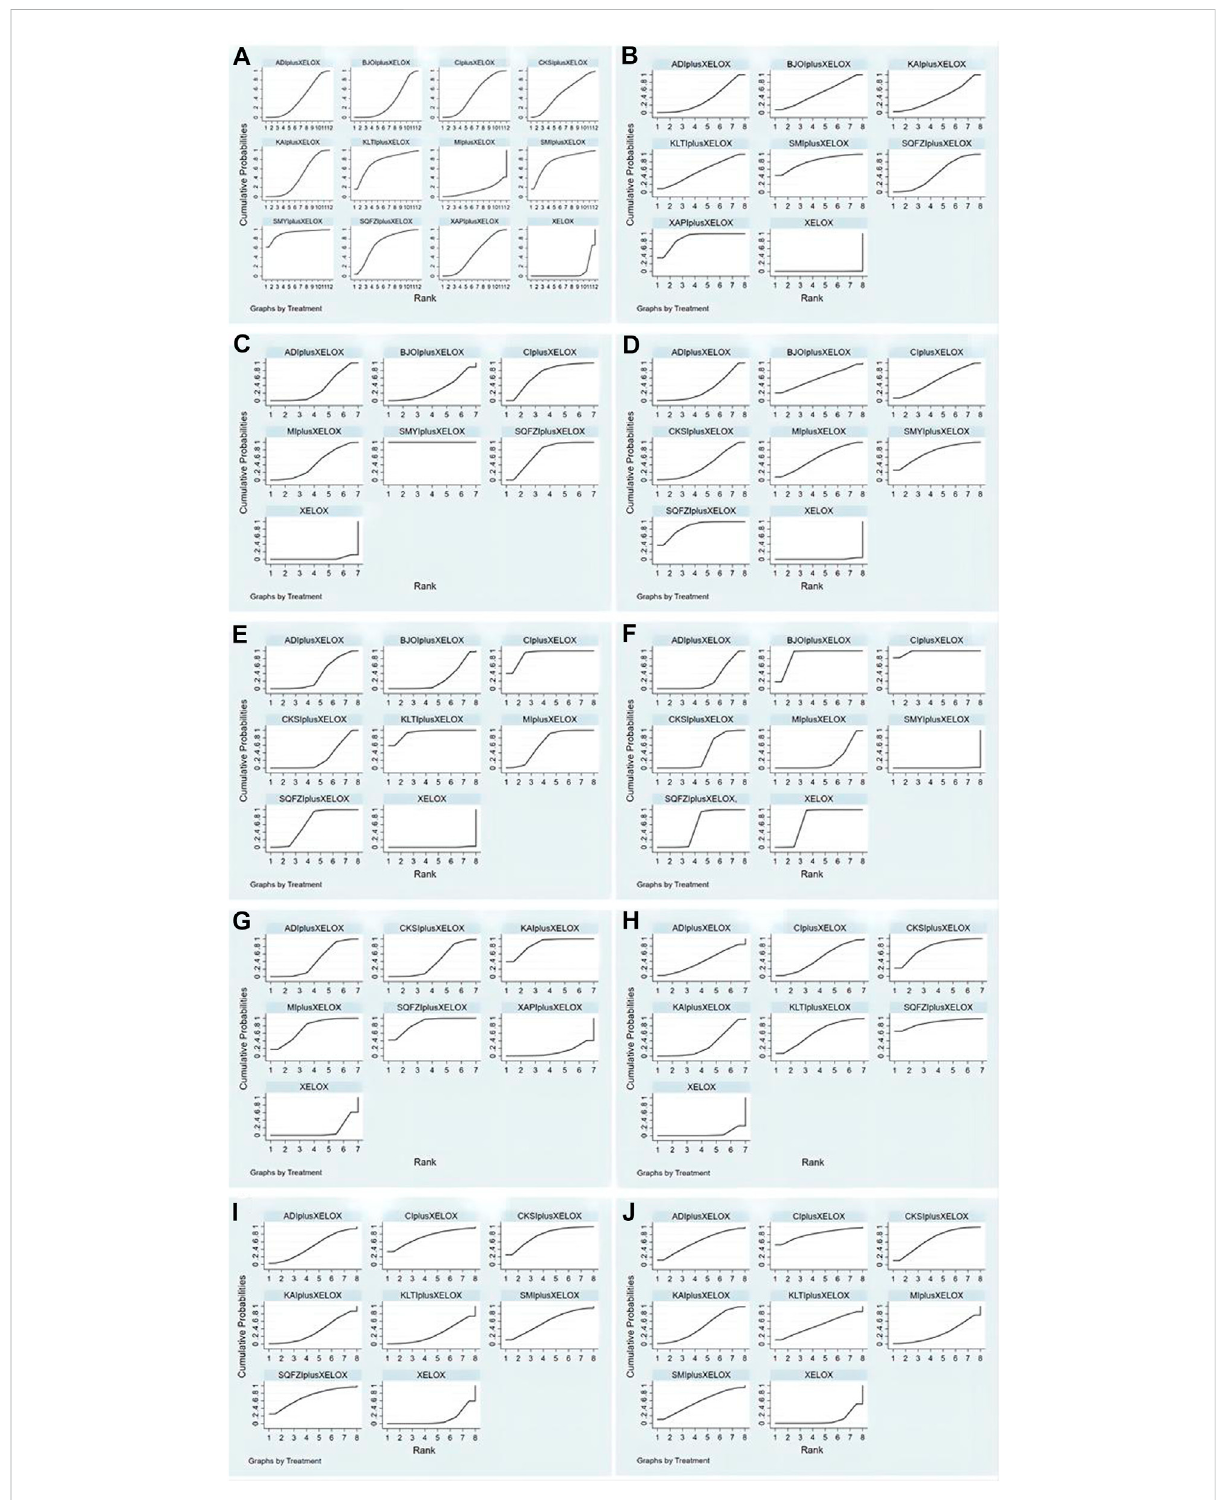
FIGURE 5 Rank of the cumulative probabilities for outcomes: (A) the clinical effectiveness rate; (B) performance status; (C) CD3 + ; (D) CD4 + ; (E) CD4+/ CD8+; (F) CD8 + ; (G) Gastrointestinal reactions; (H) Leukopenia; (I) Platelet decline; (J) nausea and